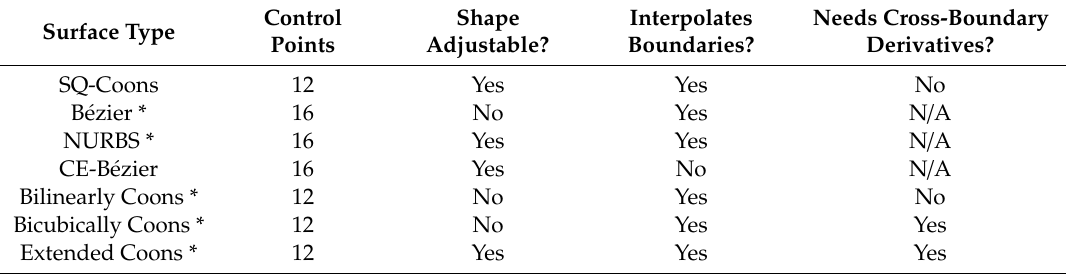
Table 1. Comparison of geometric characteristics of various types of parametric